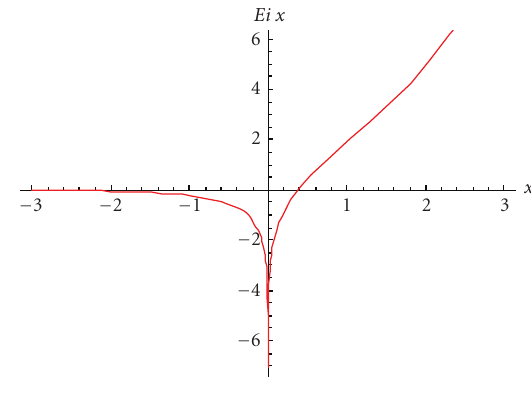
Figure 4: Exponential